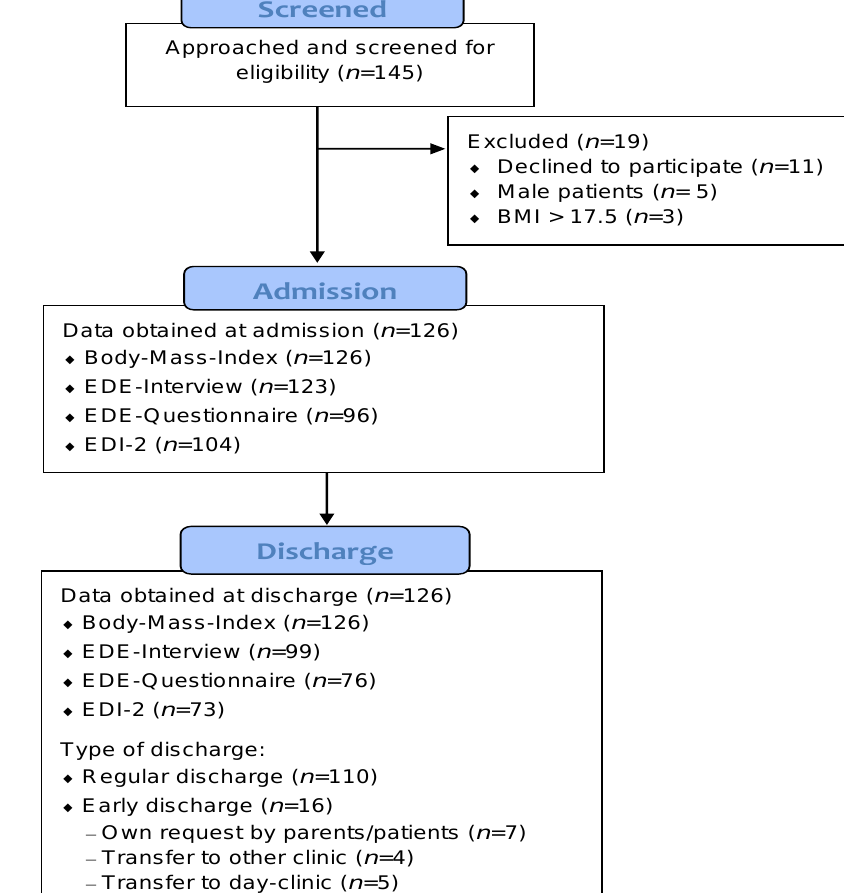
Figure 1. Parti cipants’ flow . Figure 1. Participants’